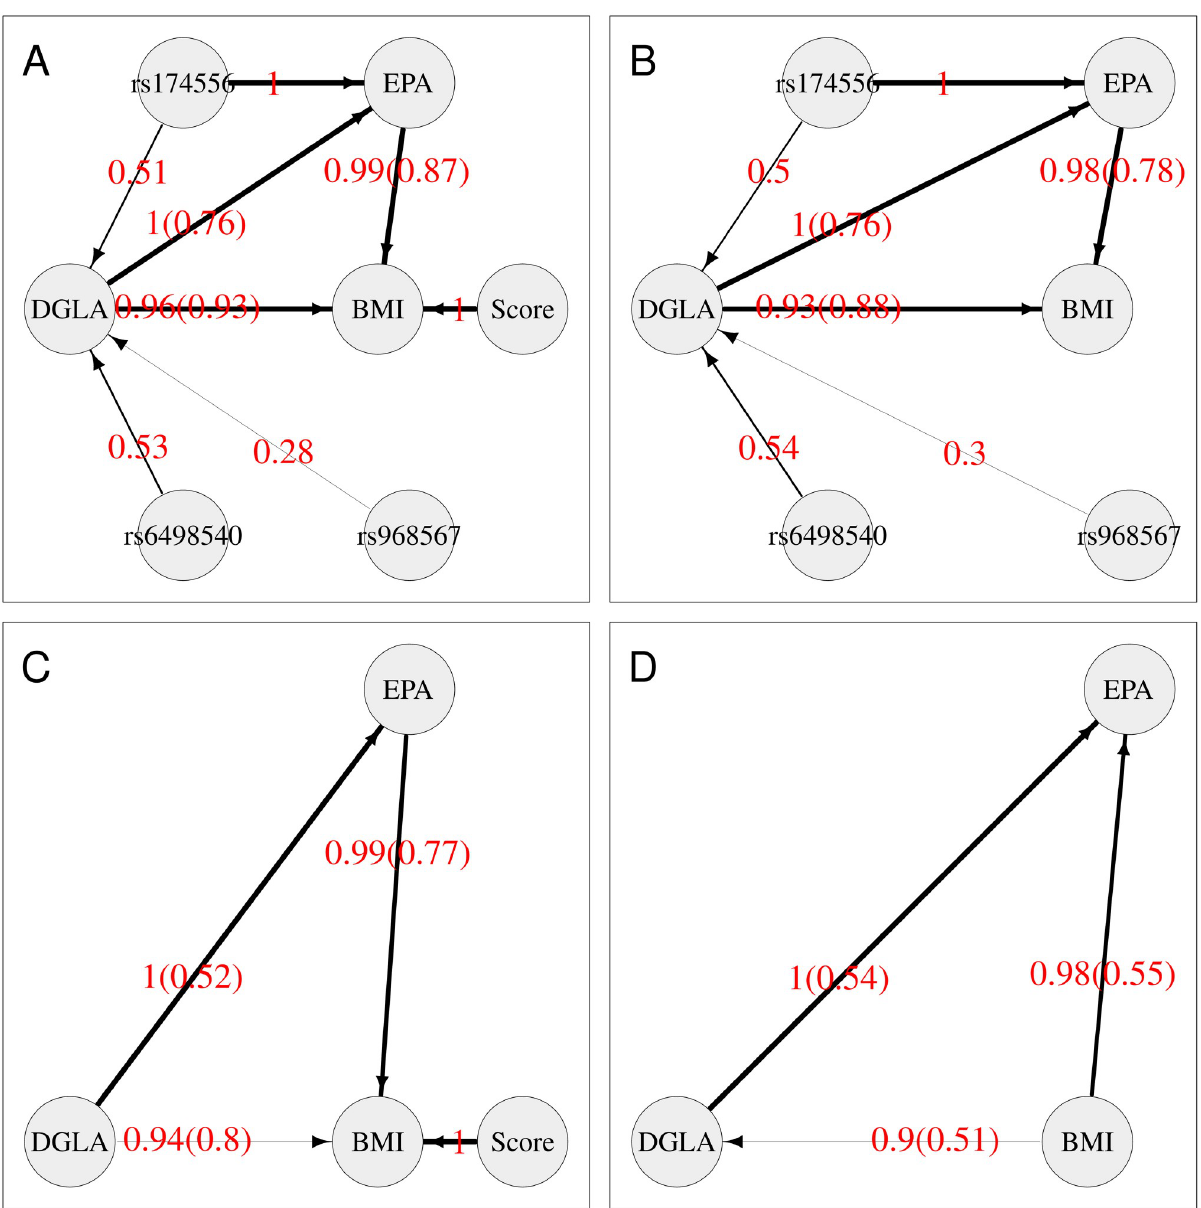
Fig 1. Average Bayesian networks for the TwinsUK data using either (A) all available variables or (B, C, D) a subset of variables, as shown. The red numbers indicate the probability of existence of the edge, and the numbers in brackets indicate the probability of the edge operating in direction shown, given that it exists. The thickness of an edge indicates its strength (probability of